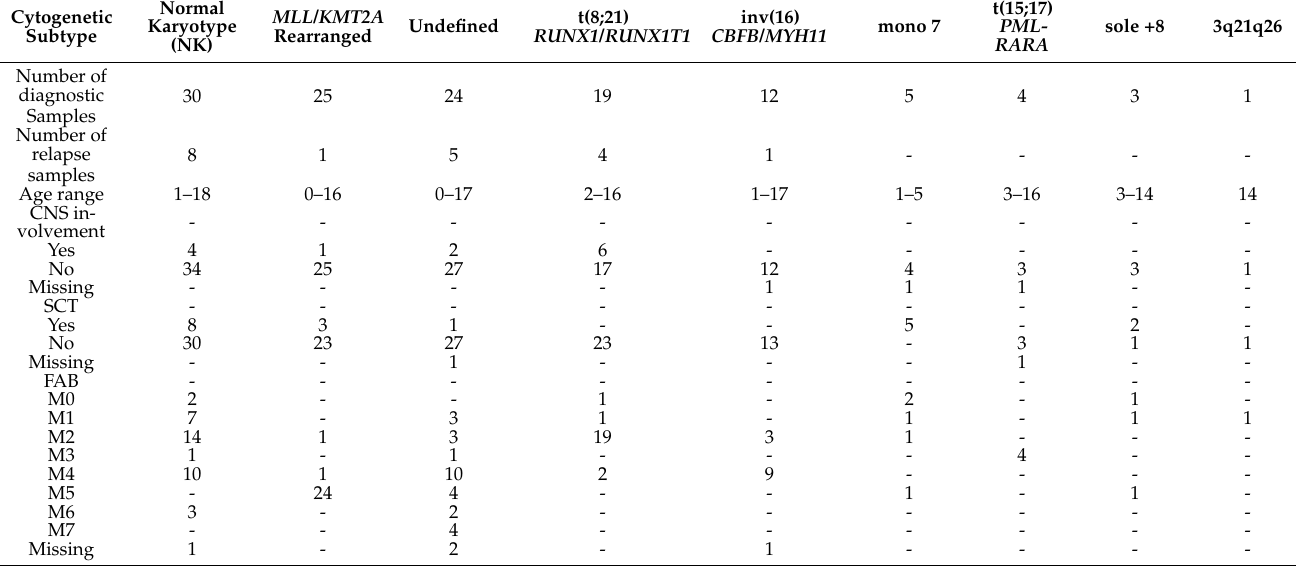
Table 1. Cytogenetic subtype, age range, central nervous system (CNS) involvement, stem cell transplantation (SCT), and FAB classification for the 142 pediatric AML patient samples. The number of samples taken at AML diagnosis and relapse are presented. When known, the subtype of the relapse samples is indicated as the same subtype as their diagnostic pair. Cytogenetic